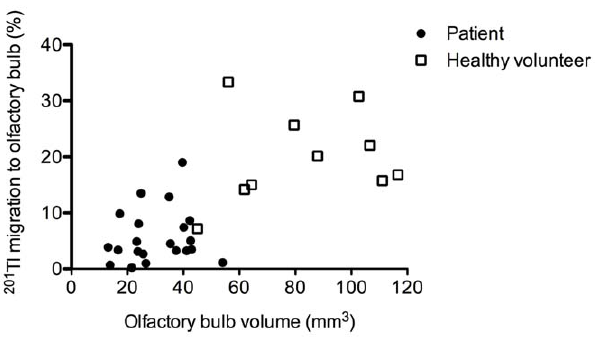
Figure 5. Correlation between olfactory 201 Tl migration and unilateral olfactory bulb volume as determined by using MRI images. Nasal 201 Tl migration to the olfactory bulb as a volume of olfactory bulb in patients and healthy volunteers (n=31). Spearman r =0.73, P , 0.0001. Closed circles, patients; Open squares, healthy